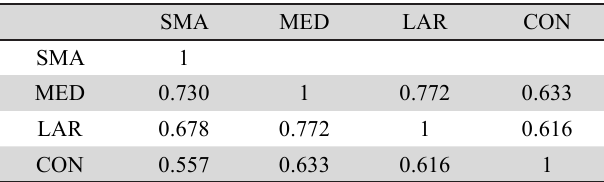
Table 4 . Ants similarity index among the studied microhabitats. SMA = Small island, MED = Medium island, LAR = Large island, CON = Continuous area.